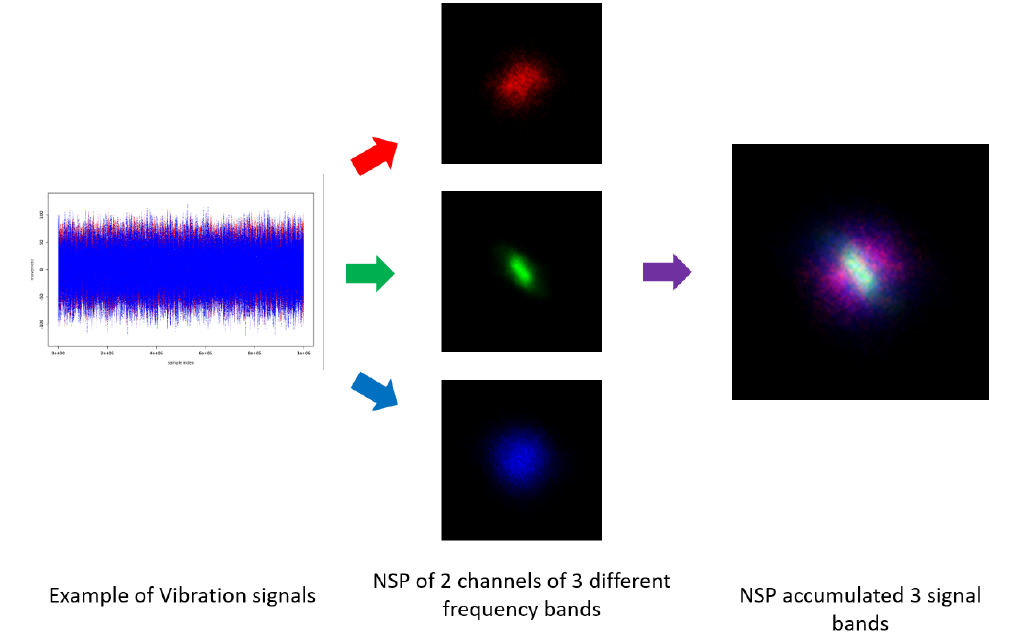
Figure 2. Bearing fault-nested scatter plot (BF-NSP)